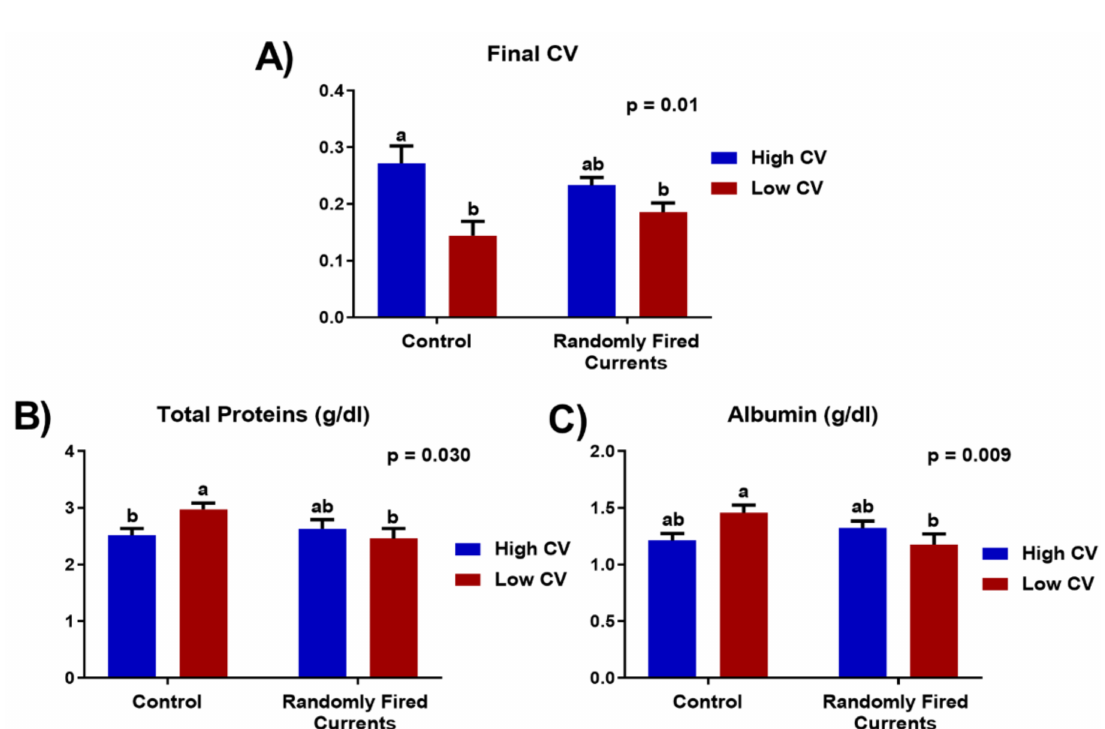
Figure 2. Interaction between CV and occupational enrichment (randomly fired currents) for final CV ( A ) and plasma concentrations of total proteins ( B ) and albumin ( C ) in Trial 1. Data presented as means ± SEM. Different letters indicate significant differences due to the interaction between current treatment and live weight CV ( p <